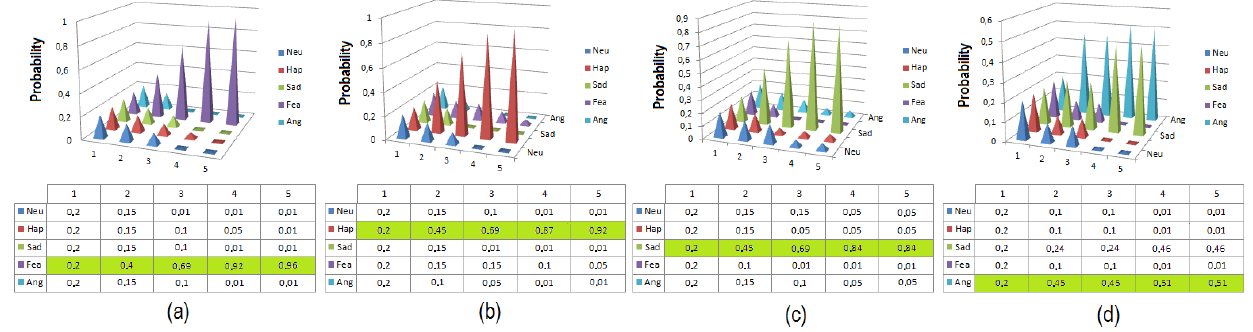
Figure 18. Results from the DBN, in the tests for imitation based on facial expression;